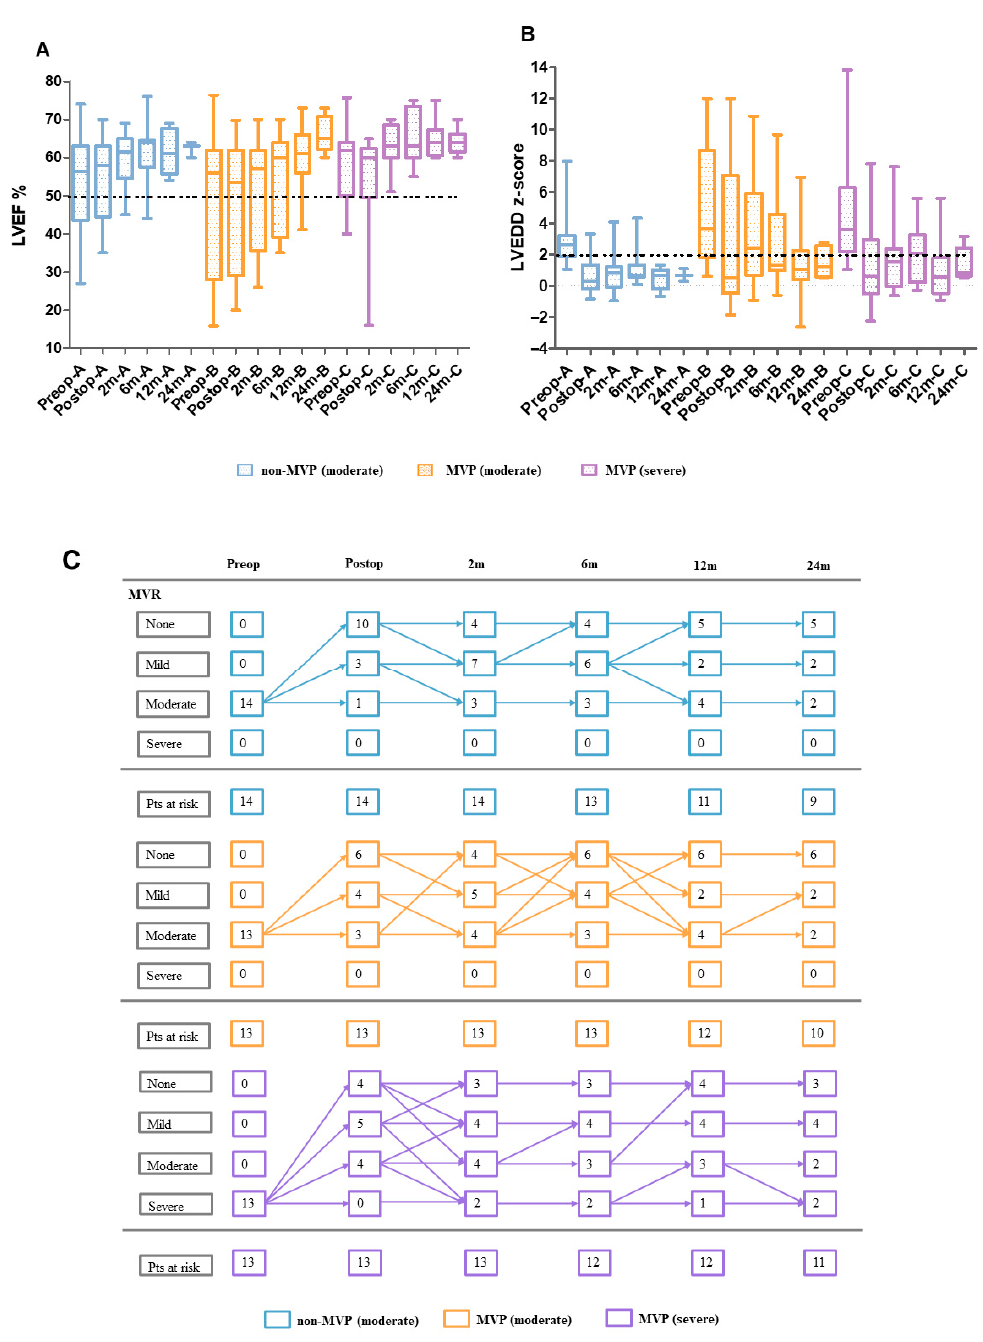
Figure 2. Longitudinal assessment for the primary outcome of ACAPA patients with and without mitral valve plasty. ( A ) LVEF% at pre-operation, post-operation, and follow-up. ( B ) LVEED z-score at pre-operation, post-operation, and follow-up. ( C ) Longitudinal changes in the degree of mitral valve incompetence with the corresponding number of patients at risk. Abbreviation: LVEED, left ventricular end-diastolic diameter; LVEF, left ventricular ejection fraction; MVR, mitral valve regurgitation; MVP, mitral valve plasty; Postop, post-operation; Preop, pre-operation; Pts, patients. For the primary effectiveness outcome, the LVEF and LVEDD z-score at 2 m follow-up of the non-MVP (moderate) group were significantly better than that of the MVP (moderate) group (LVEF: β = 9.22, 95%CI, 1.09 to 17.35; LVEDD z-score: β = − 2.49, 95%CI, − 4.53 to − 0.45) after adjusting for age and gender (Table 2).